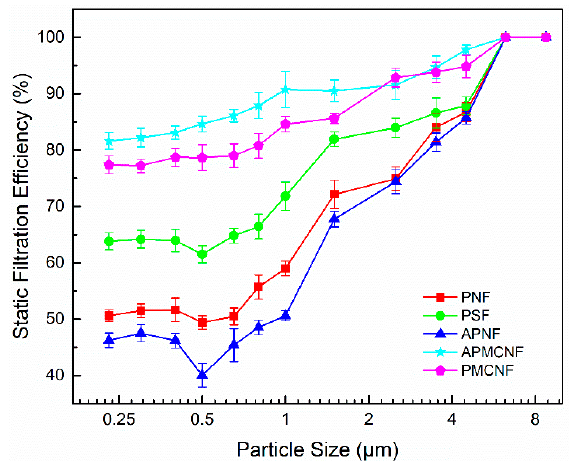
Figure 5. The classification filtration efficiencies of the clean filter media for particles at a filtration velocity of 1m ∙ min –1 .